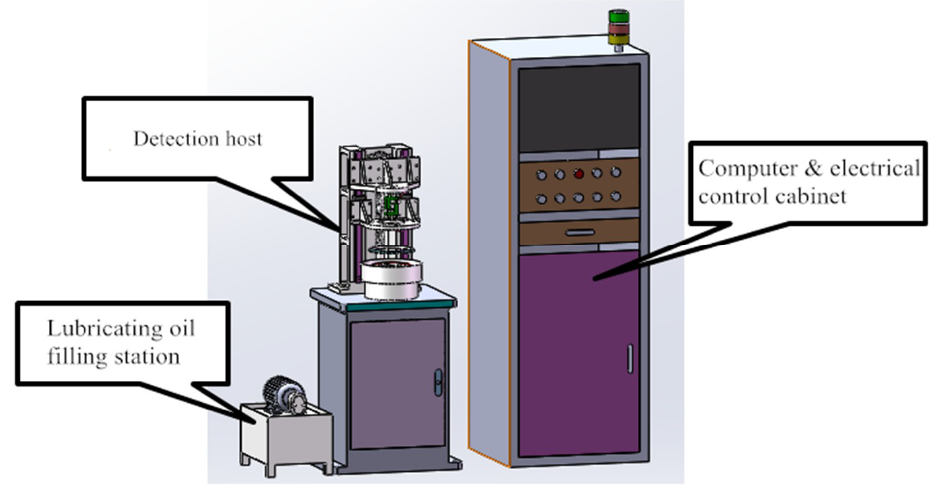
Figure 9. Schematic diagram of the synchronizer detection device.